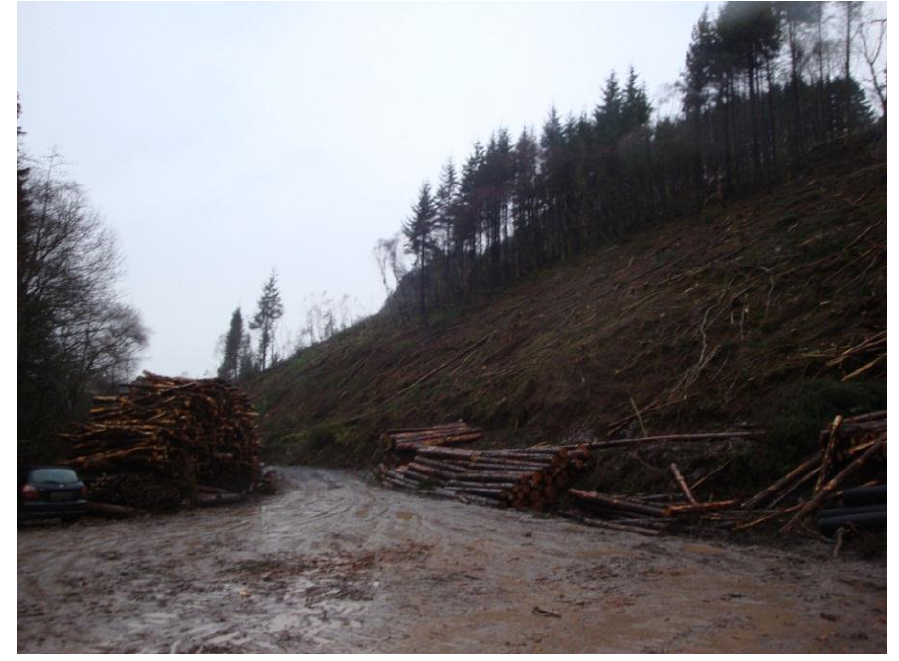
Figure 6. Panoramic view of Clonmel cable log SC